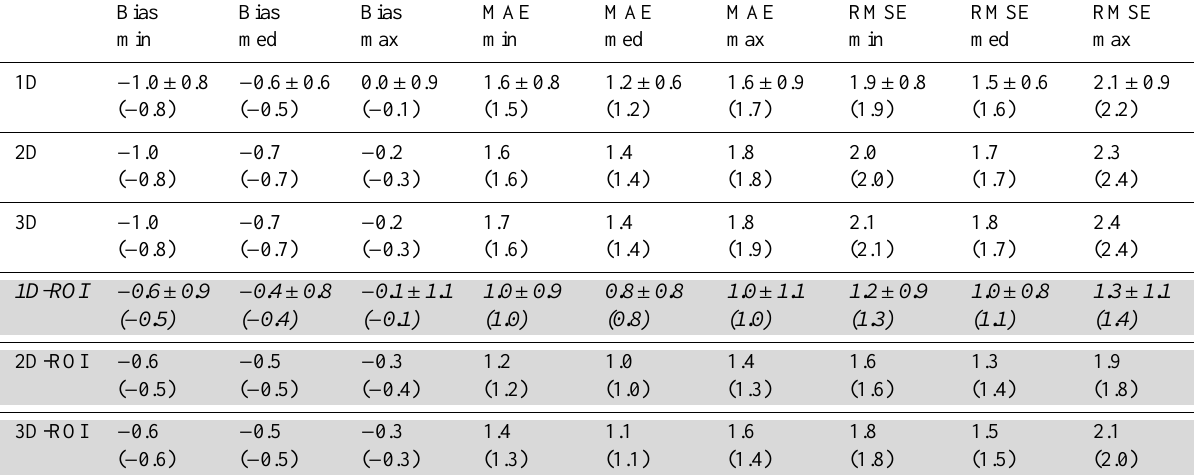
Table 2. Bias ( ◦ C), MAE ( ◦ C), and RMSE ( ◦ C) averaged for land grid points respect to the analyses. Values for each grid point are computed for the whole period. The rows show the results of each forecast day. Min, med, and max refers to minimum, mean and maximum temperature, respectively. The analysis error is shown only for the first-day and is equal for all days. The values in parentheses are the statistics for the analyses grid-points nearest to the observations. Shaded rows: statistics computed respect to ROI-analyses. The first-day ROI row (in italic) is not intended for verification purposes but shows the performance of the OI scheme using the RAMS first-day forecast as background